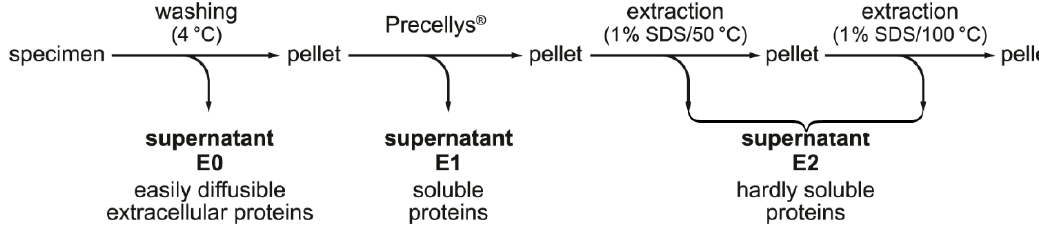
Figure 7. Schematic representation of the stepwise extraction protocol of gastric specimens.